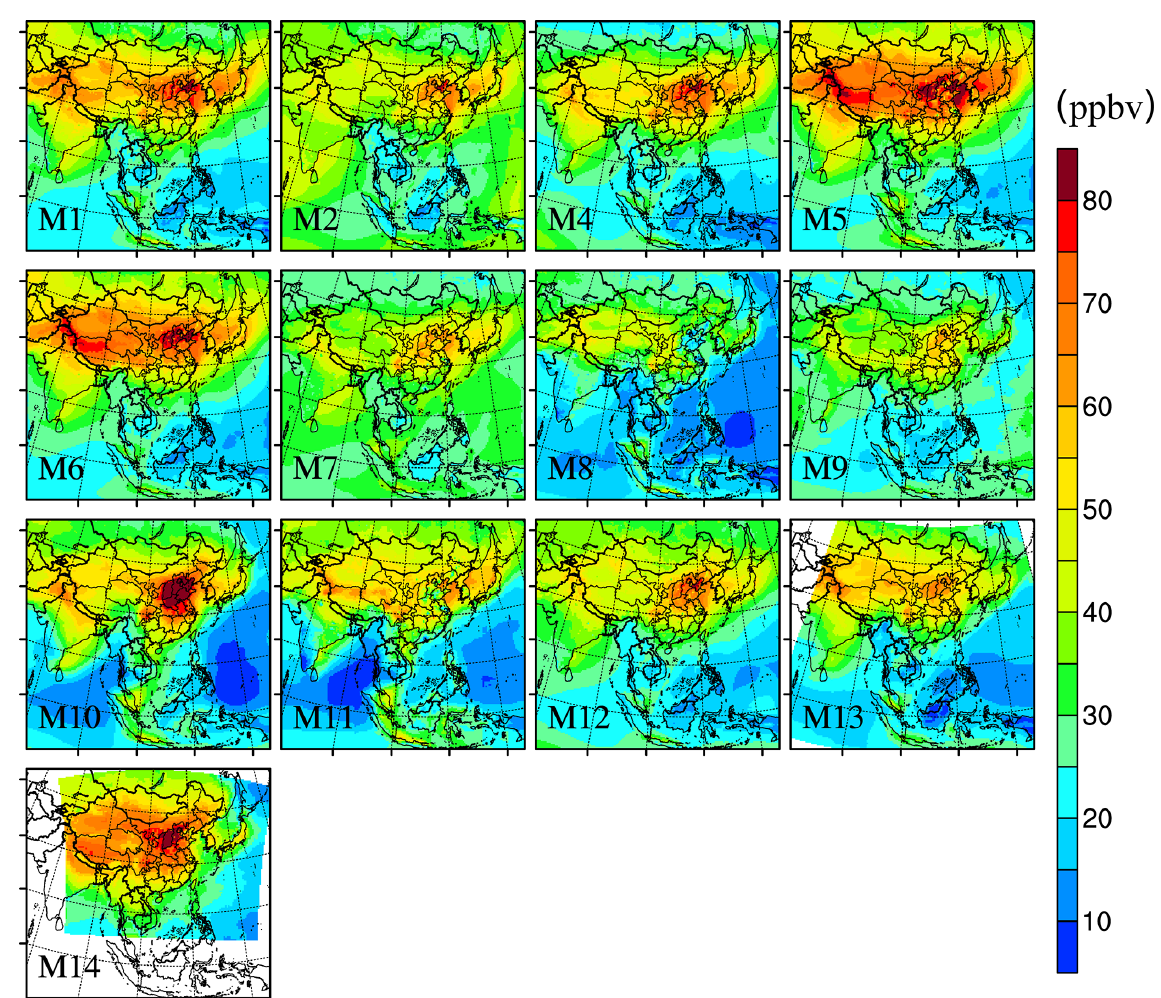
Figure 7. Surface O 3 spatial distribution derived from 13 models for summer 2010 (units in